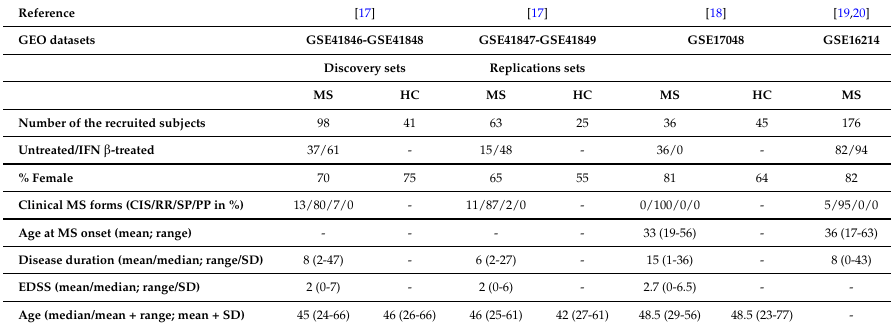
Table 6. Main features of the clinical/demographic characteristics of the related